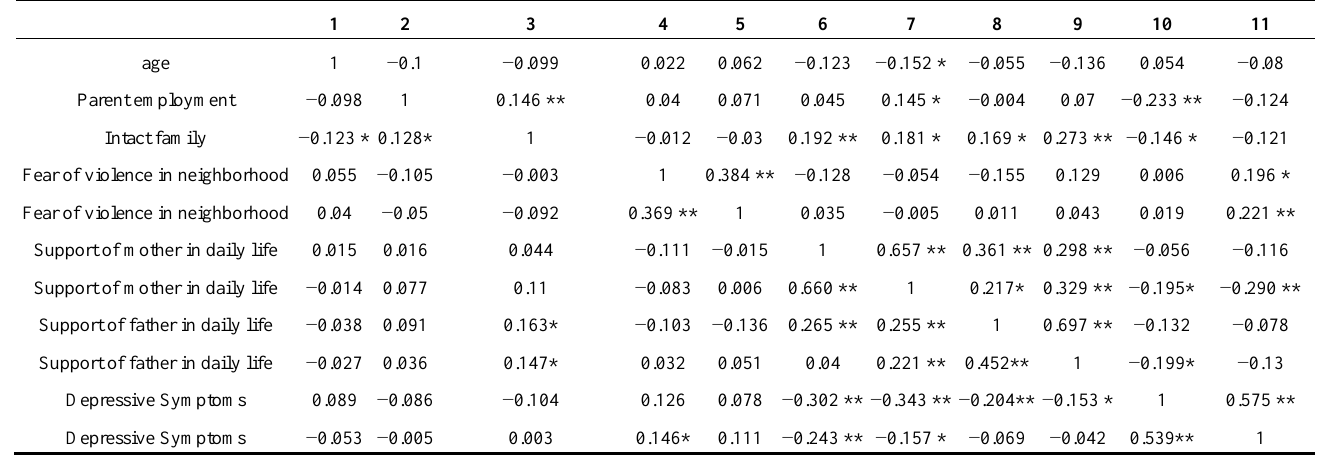
Table 2. Correlation matrix among male and female African American